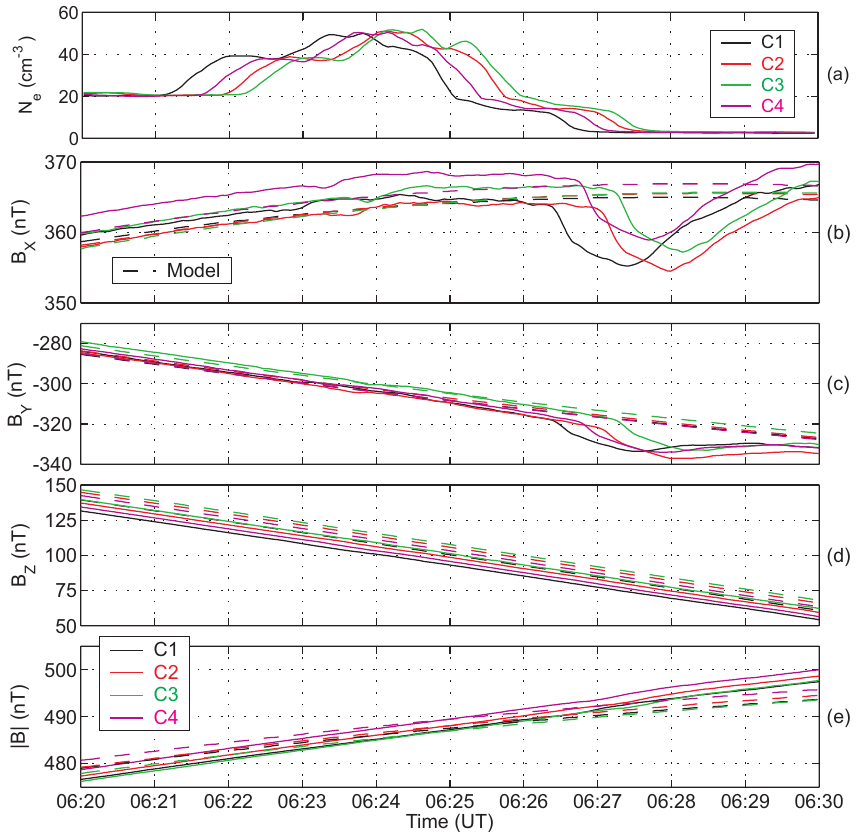
Fig. 18. Similar as Fig. 17 for the outbound plume crossing of 11 April 2002.